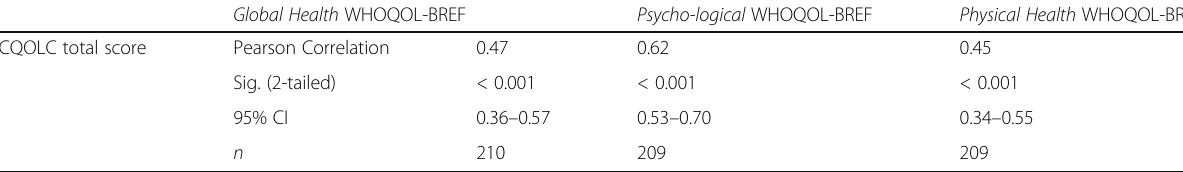
Table 4 Correlations with the CQOLC total score (hypotheses 1 and 2) Global Health WHOQOL-BREF Psycho-logical